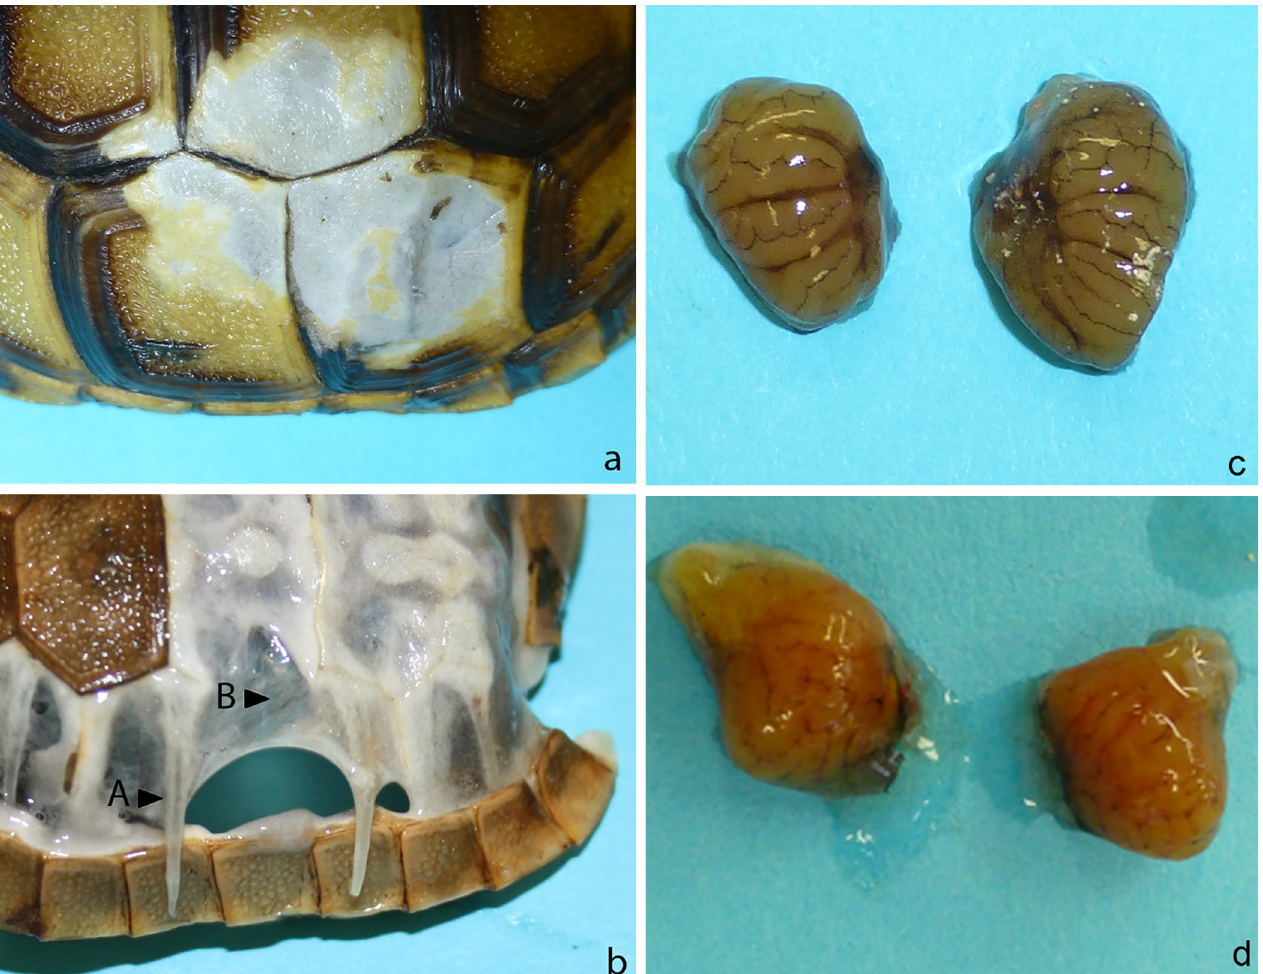
Fig 5. Comparison of carapace structure and kidneys in infected and non-infected tortoises. a: Carapace of control animal T . graeca CG1 ; b: Carapace of animal T . graeca G9; c: Kidneys of control animal T . graeca CG1 d: Kidneys of T . graeca G9 The carapace of G9 shows only thin rib bones (A) with fibrous tissue in between (B), in the control animal the intercostal space is filled with bone matter The kidneys of the infected animal are swollen and the natural structure is not visibleas in the kidneys of the control animal.